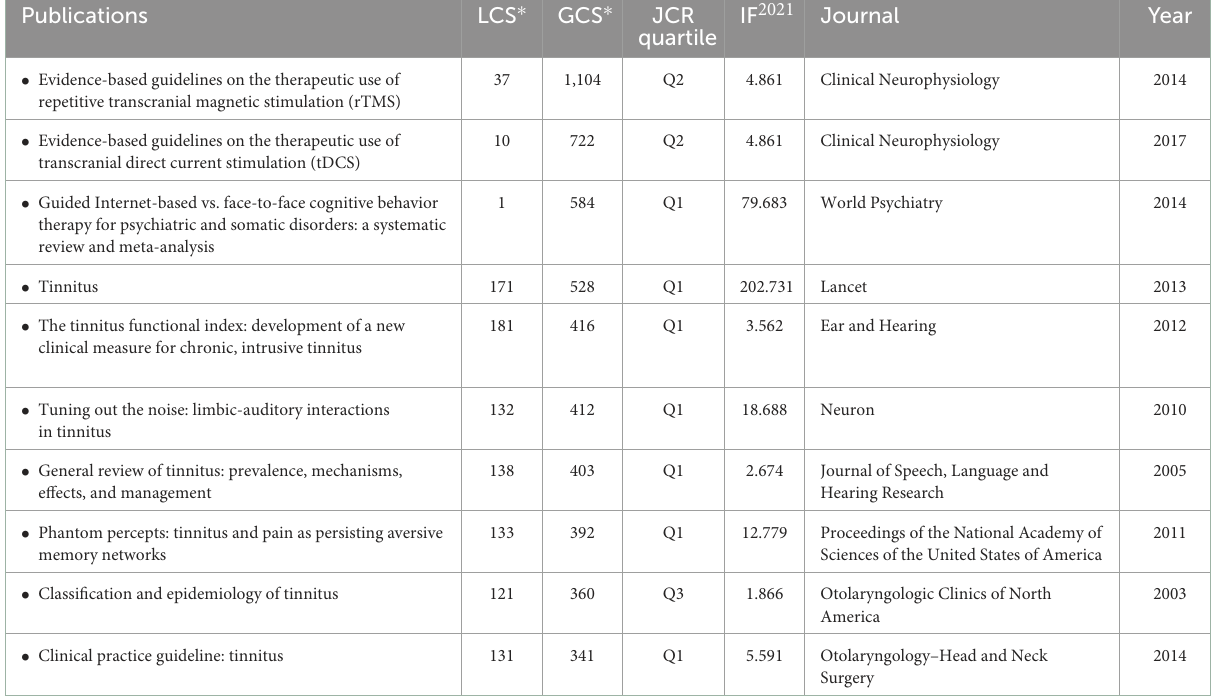
TABLE 2 The characteristics of the most referenced and impactful top 10 classic papers in the field of tinnitus treatment.